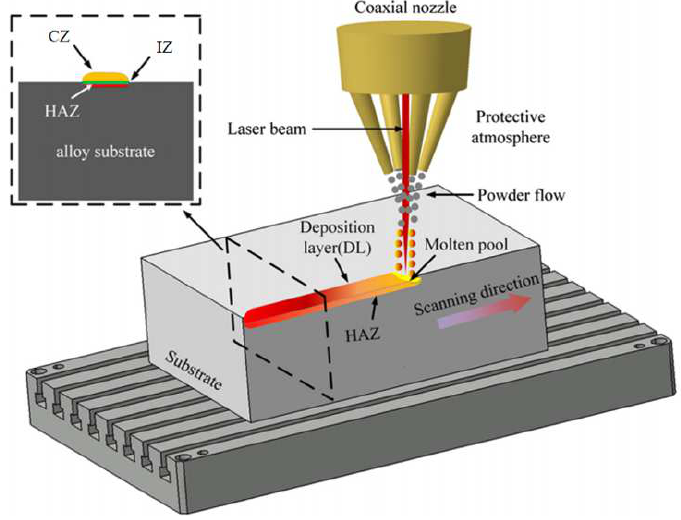
Figure 1. The schematic diagram of the LMD process [24].